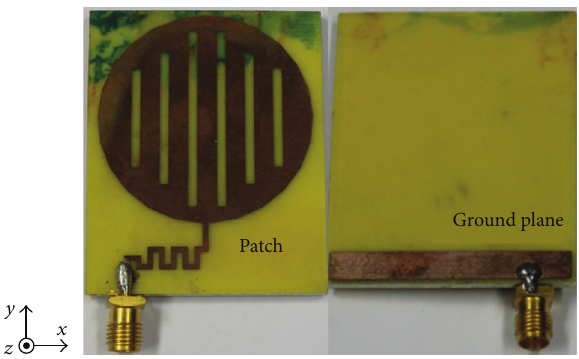
Figure 4: Photograph for the prototype of the proposed antenna.